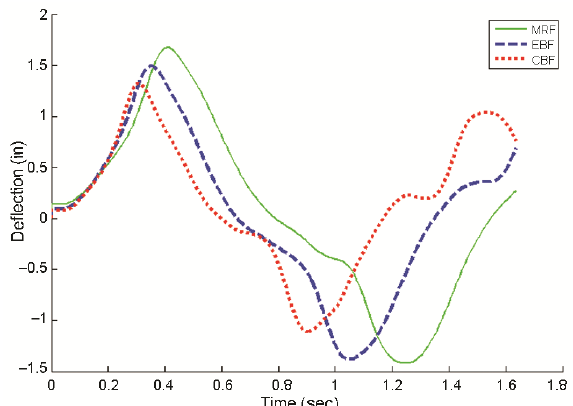
Fig. 12. Roof deflection under 2-K (8.9 kN) blast (1 in. = 25.4 mm)